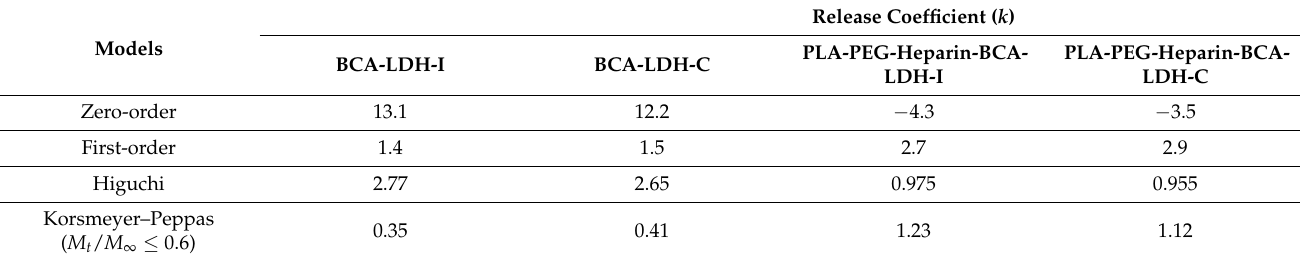
Table 2. Release coefficient of mathematical model fitting of drug release